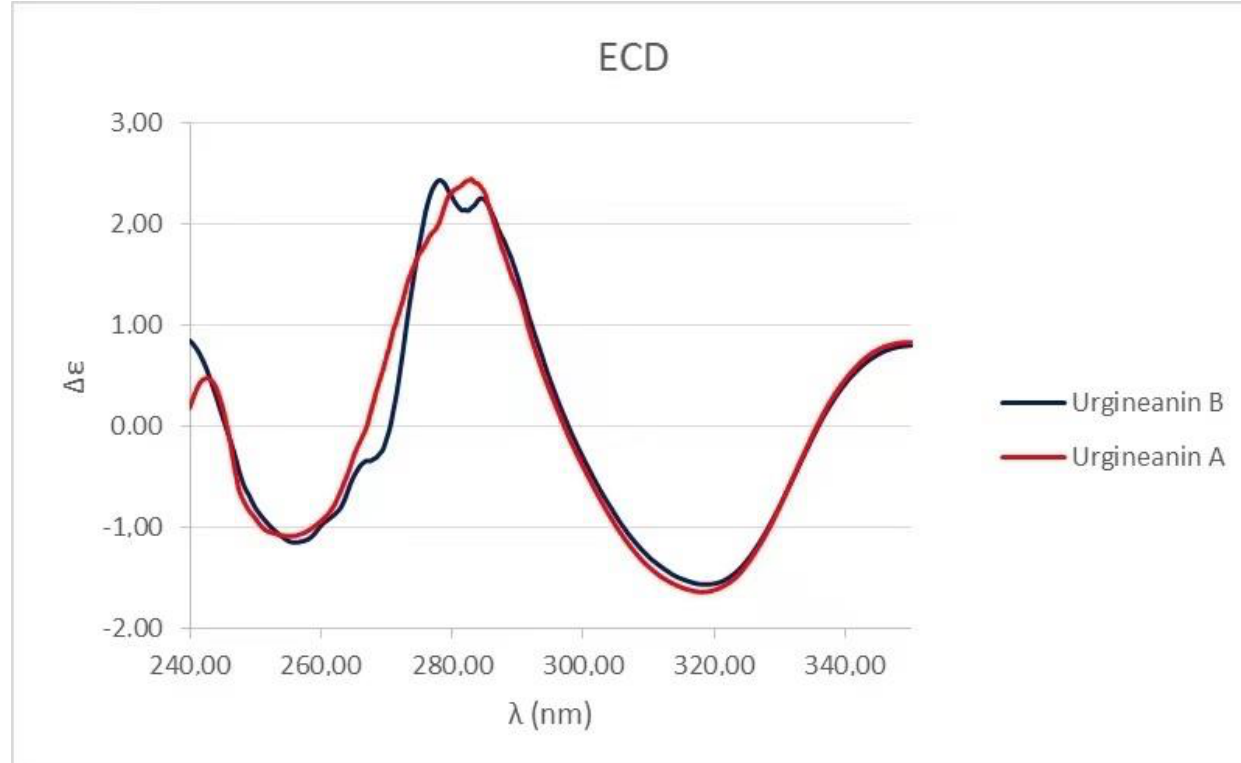
Figure 4. Experimental ECD spectra of homoisoflavanoids ( 1 ) (black solid line), and 4 (red line).